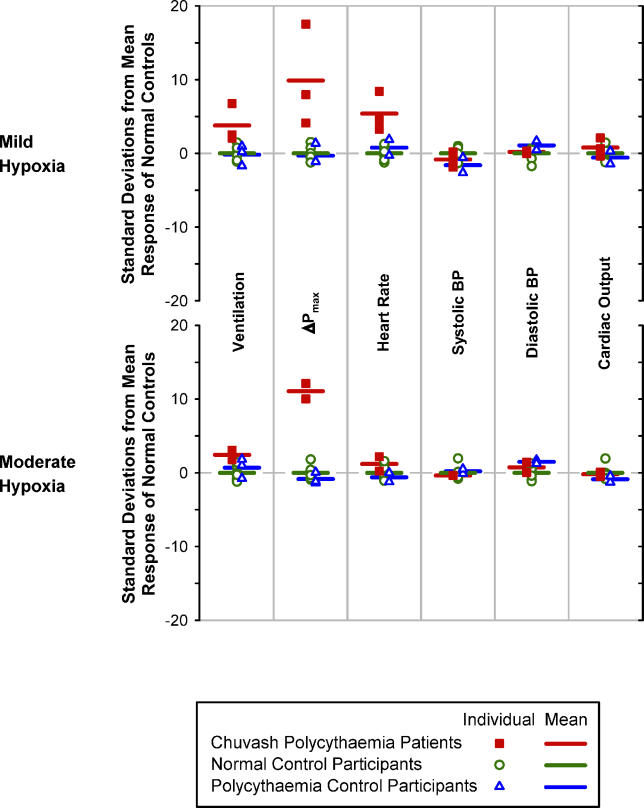
Sensitivities to Hypoxia for Individual ParticipantsResults are shown in terms of the number of (normal control group) standard deviations by which each participant's response differed from the mean response of the normal control participants. The patients with CP were significantly different from the normal control group in their ventilatory and pulmonary vascular responses to both mild and moderate hypoxia, and in their heart rate responses to mild hypoxia. BP, blood pressure.